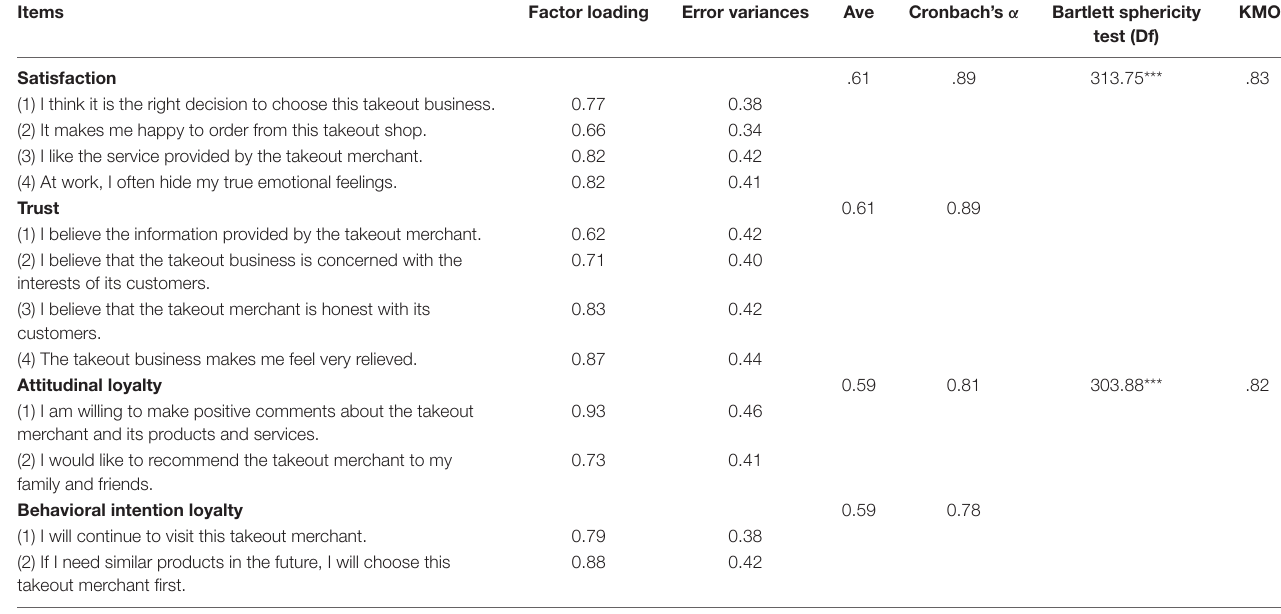
TABLE 3 | Results of the confirmatory factor analysis on relationship quality and customer loyalty. Items